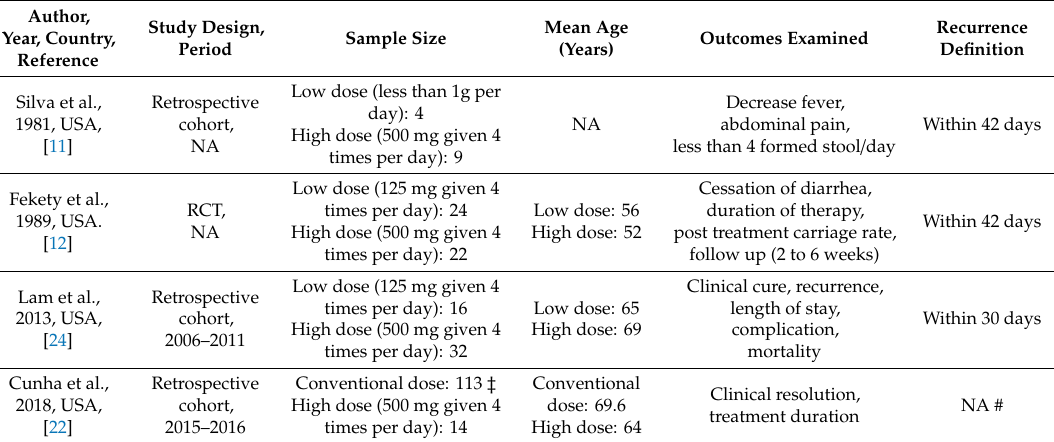
Figure 1. PRISMA Flow Diagram for study selection. Table 1. Characteristics of the four articles included in this study.